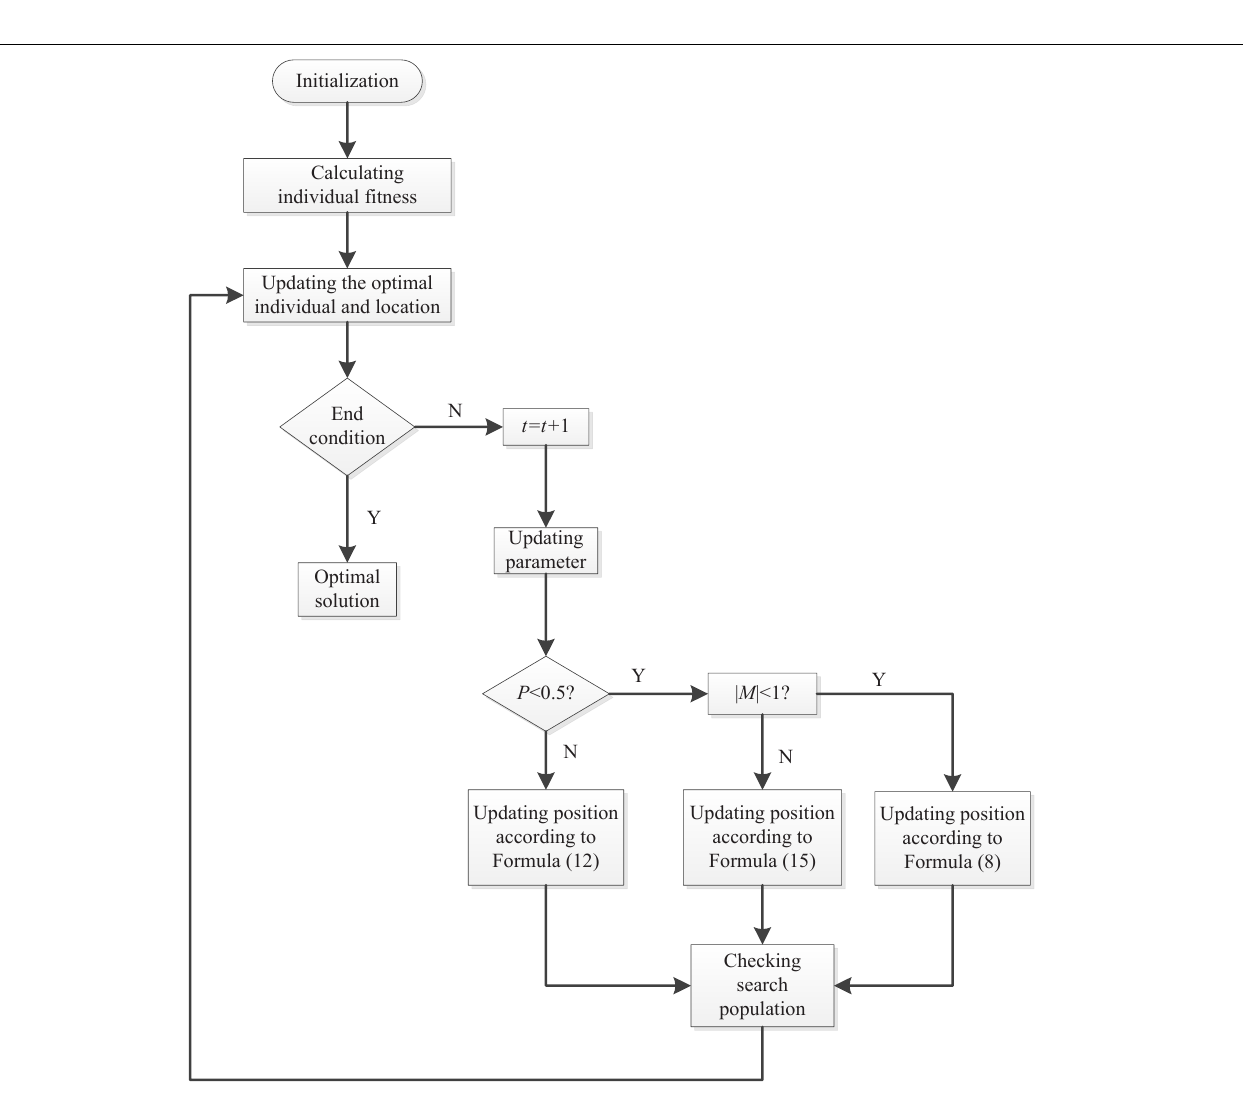
FIGURE 2 | Flowchart of WOA.